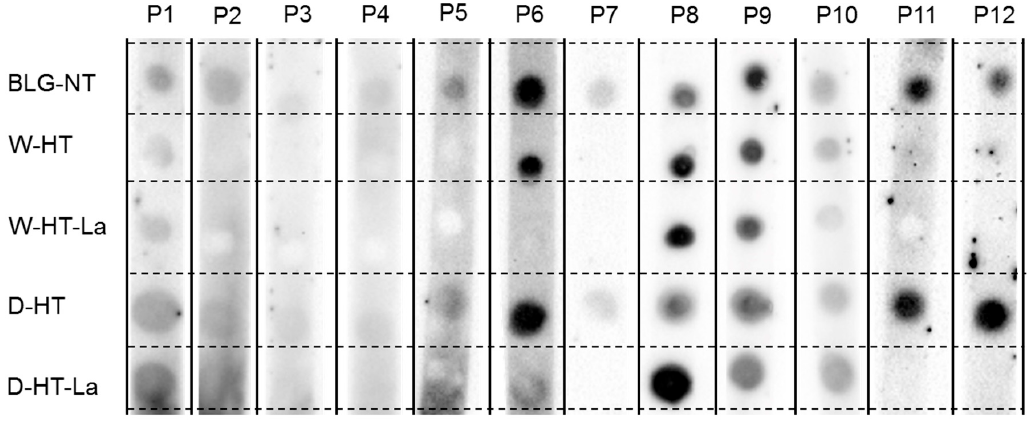
Figure 7. sIgE dot blot membranes of sera from 12 different patients (P) tested for their binding affinity to unheated BLG (BLG-NT) and BLG heated at high temperatures (HT) either under wet (W) or dry (D)